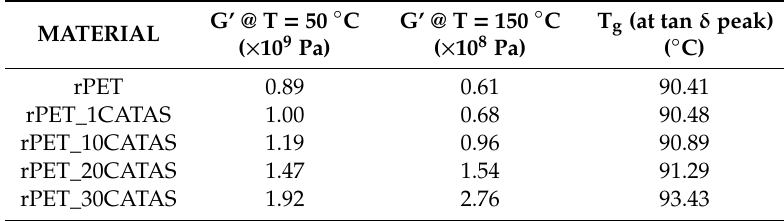
Figure 3. G’ ( a ) and tan δ curve ( b ) from DMTA tests for rPET and rPET / CATAS nanocomposites. Table 2. Calculated values of tan δ and G’ at 50 and 150 °C for the rPET/CATAS nanocomposites.